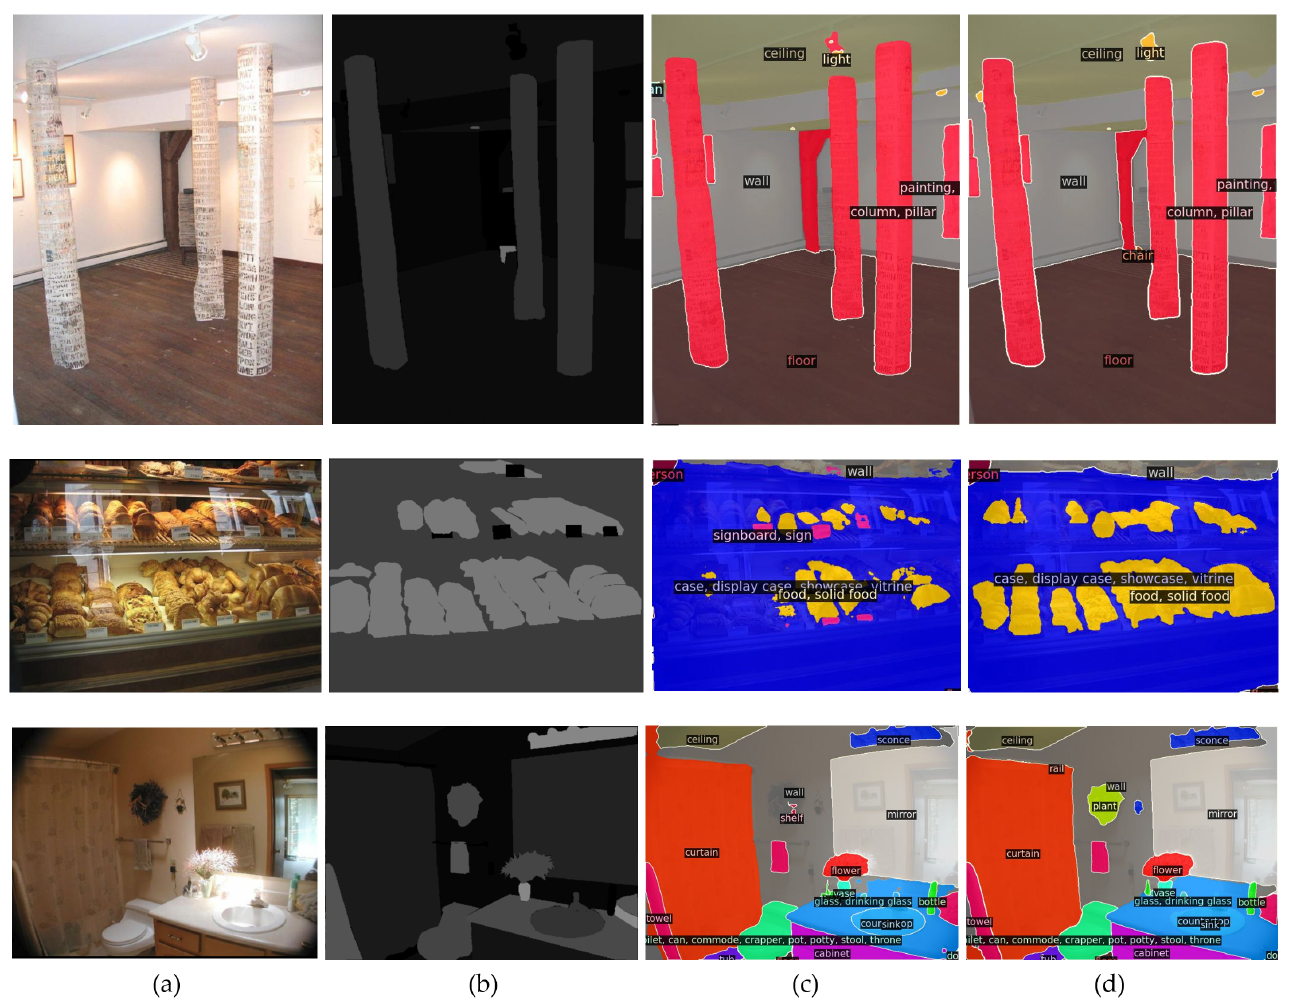
Figure 2. Semantic segmentation results based on the ADE20K validation dataset. ( a ) RGB input, ( b ) ground truth, ( c ) baseline method, and ( d ) our proposed method. The proposed method using the auxiliary CNN improves the detection of local information and small objects compared with the baseline method